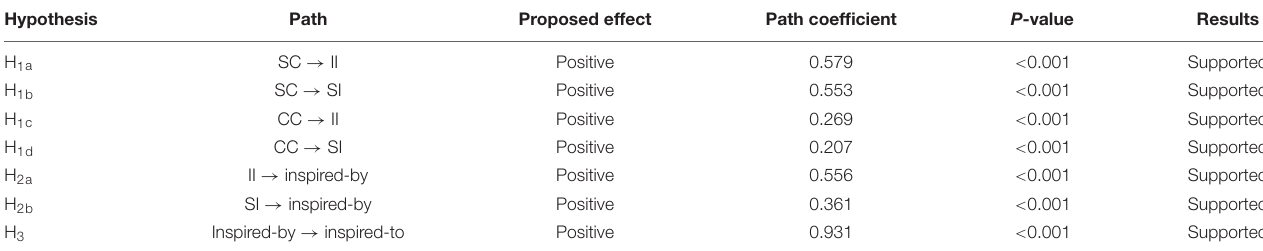
TABLE 4 | Results of hypothesized